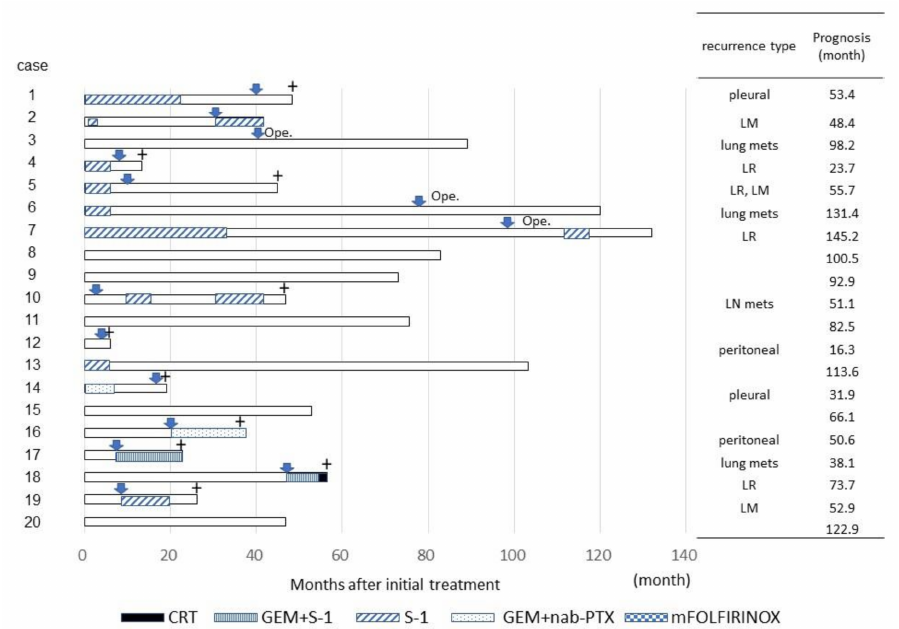
Figure 2. Clinical characteristics of the 20 patients who underwent conversion surgery including therapy after operation. Abbreviations: pleural, pleural disseminations; LM, liver metastasis; lung mets, lung metastasis; LR, local recurrence; peritoneal, peritoneal disseminations; directing arrow, recurrent or metastatic period; Ope, additional operation; +, period of